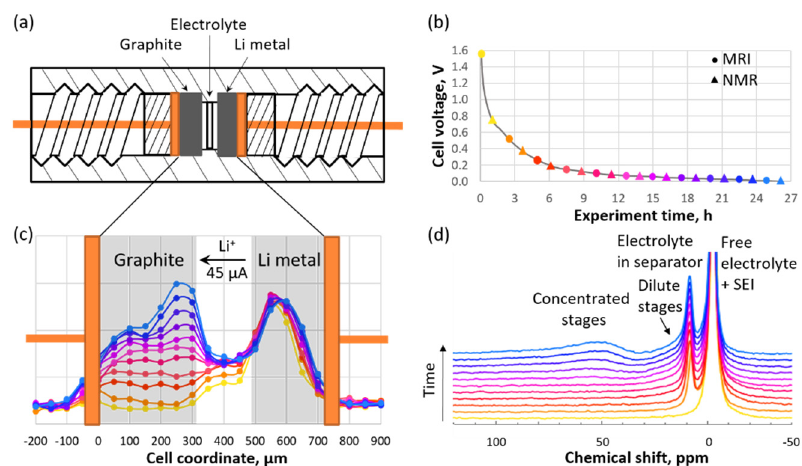
Figure 5. ( a ) Schematic representation of an in situ cell. ( b ) Voltage vs. time curve for graphite during the first charging stage. ( c ) Axial 7 Li MR images. ( d ) 7 Li NMR spectra collected during charging. The circles of a given color in panel ( b ) correspond to the curves with the same colors in panel ( c ), while the triangles correspond to the curves with the same colors in panel ( d ). (Reproduced with permission from [57]; Copyright 2018 American Chemical Society).